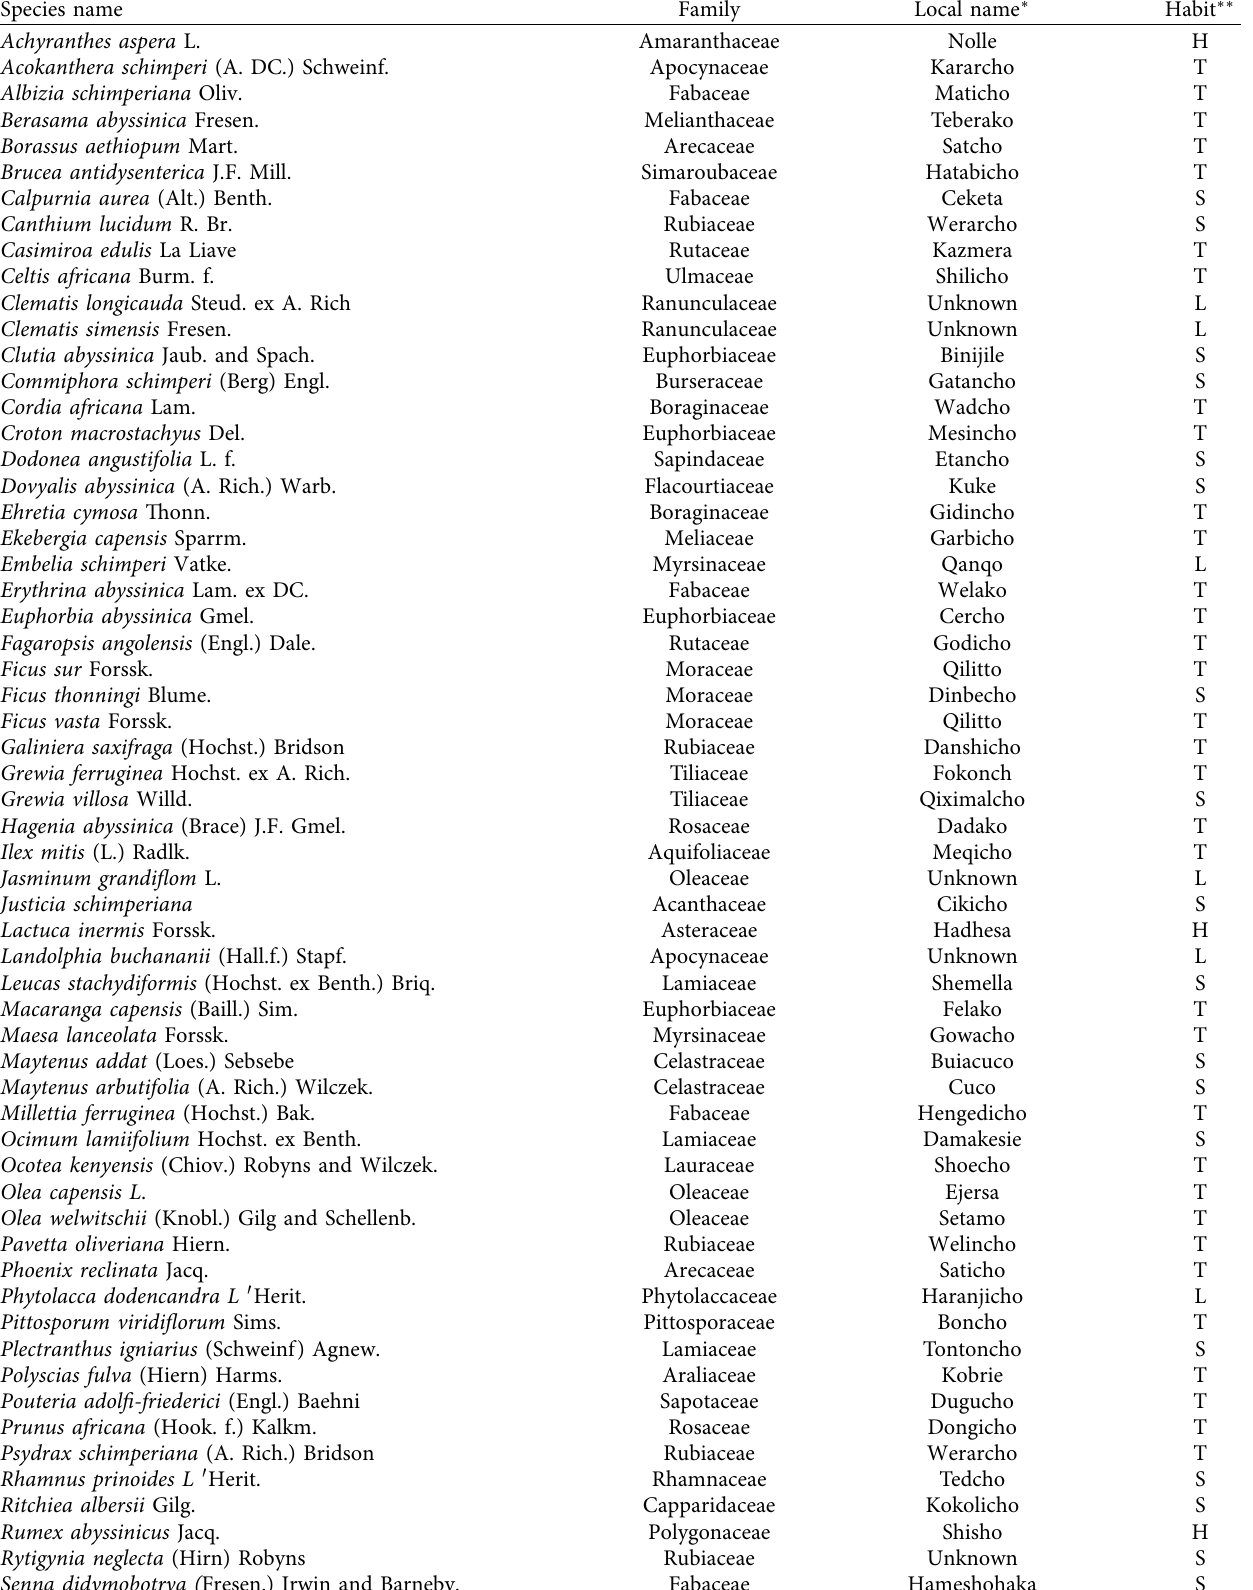
Table 1: List of woody plant species recorded from Abbo Sacred